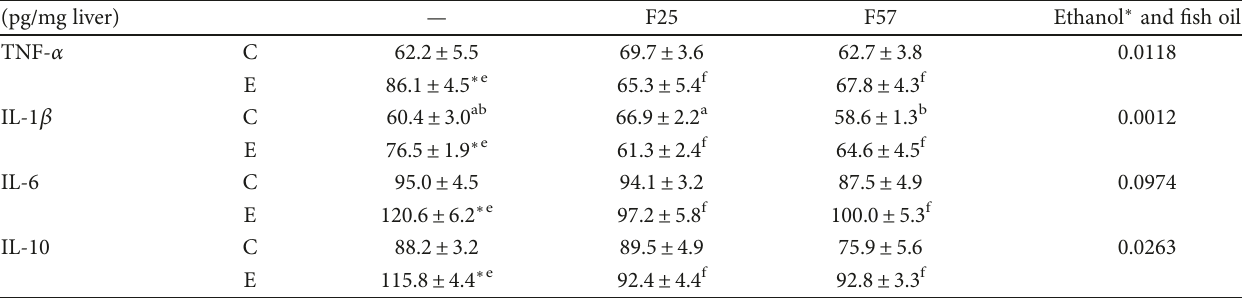
Table 5: Hepatic tumor necrosis factor- (TNF-) α , interleukin- (IL-) 1 β , IL-6, and IL-10 levels in each group 1,2 . (pg/mg liver)